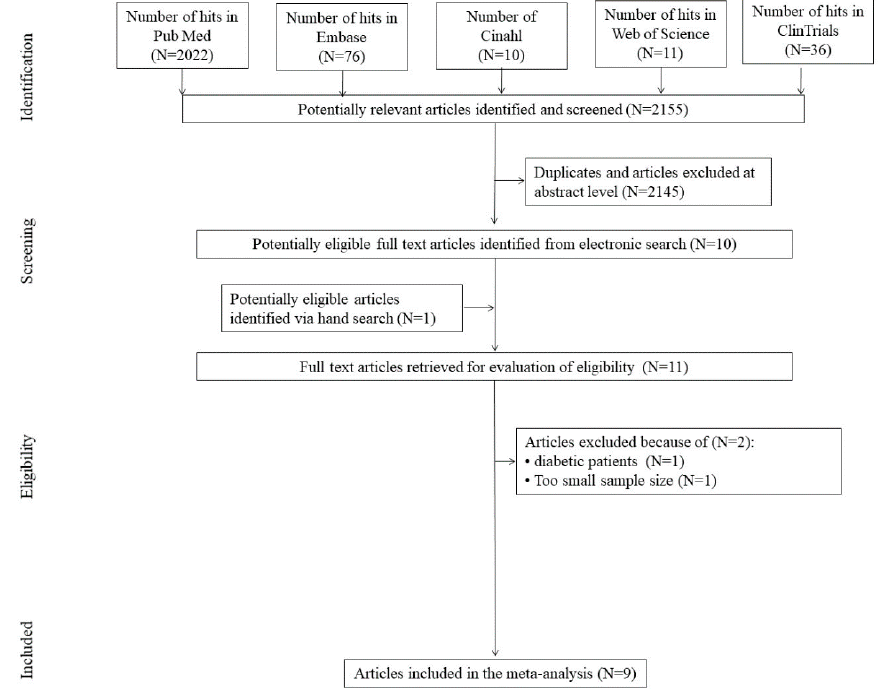
Figure 1. Preferred Reporting Items for Systematic Reviews and Meta-Analyses (PRISMA) study flowchart depicting search strategy and study selection.